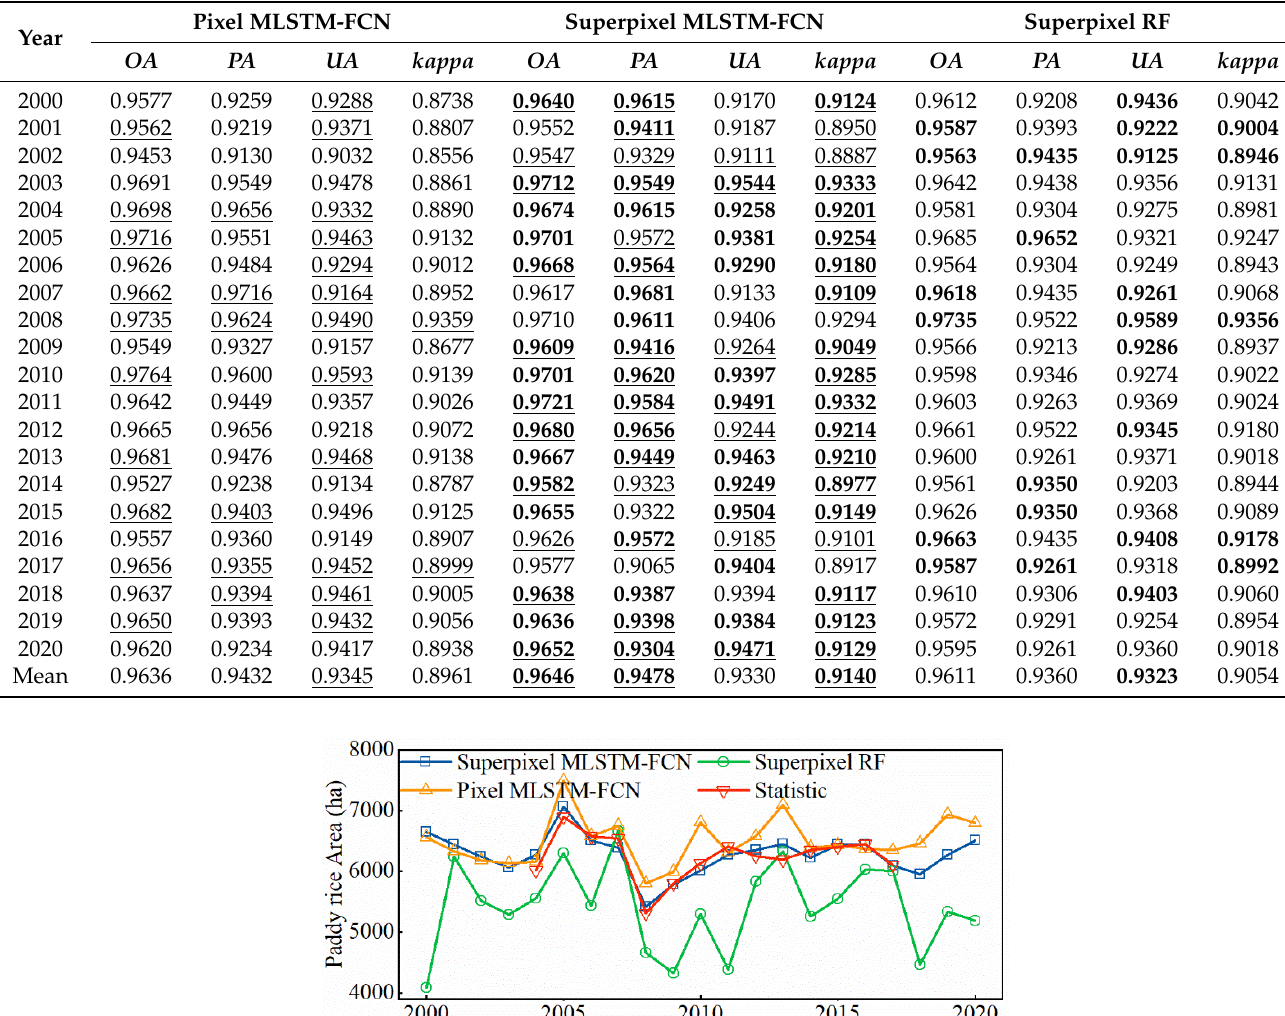
Figure 6. Mapped paddy rice area by three classification models from 2000 to 2020.